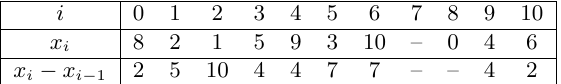
Table 6: Information used to obtain the type for the starter in Z 11 , which is 1 2 2 2 3 1 since there are two differences repeated only once (namely 5 and 10), two differences repeated twice (namely 2 and 7) and one difference repeated three times (namely